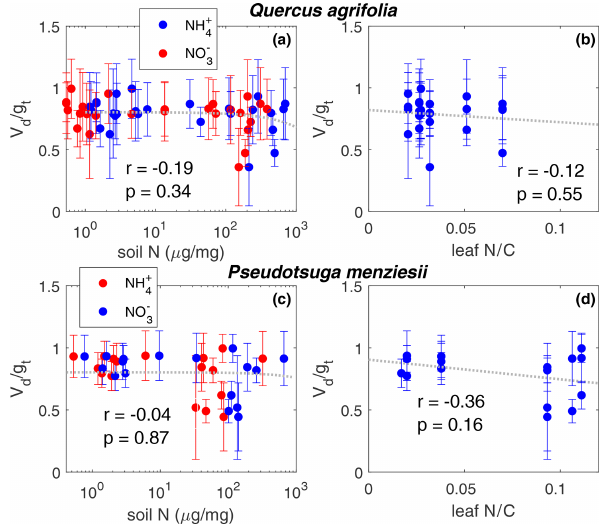
Figure 4. The V d /g t ratio is plotted against soil nitrogen concen- tration in the form of NH + and NO − for (a) Q. agrifolia and (c) P. 4 3 menziesii . The dashed line shows a linear fit to NH 4 data. The re- lationship is not significantly different ( α = 0 . 05) when fit to NO − 3 data. The V d /g t ratio is plotted against the leaf nitrogen:carbon ra- tio for (b) Q. agrifolia and (d) P. menziesii . V d /g t ratios less that 1 imply contributions from the mesophyll to the NO 2 uptake rate. On each panel the Pearson’s correlation coefficient and the p value for the slope are shown. The amount of soil and leaf nitrogen has no significant impact on the V d /g t